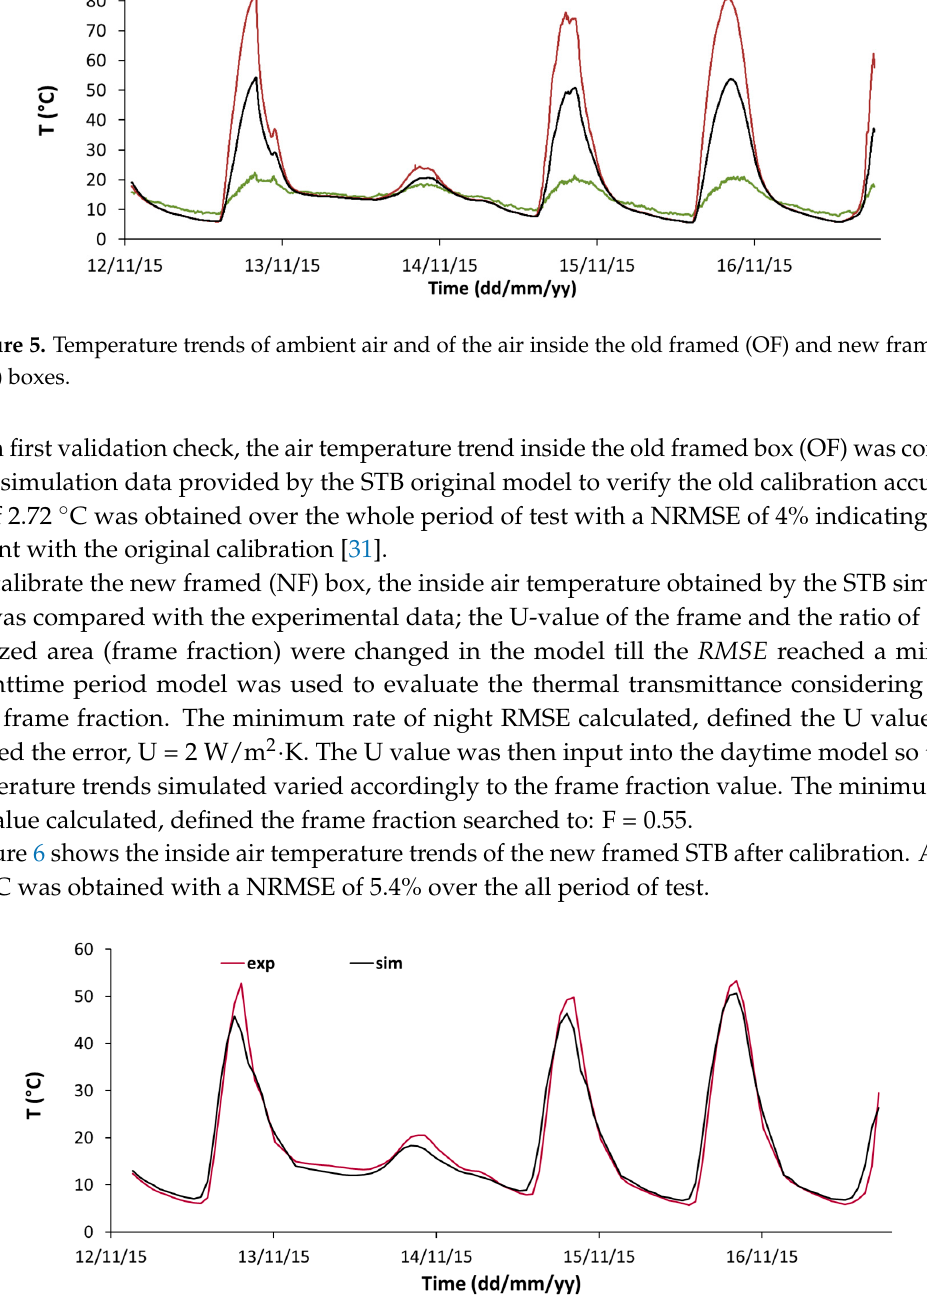
Figure 6. Temperature profiles of NF, measured and simulated, after the calibration procedure.